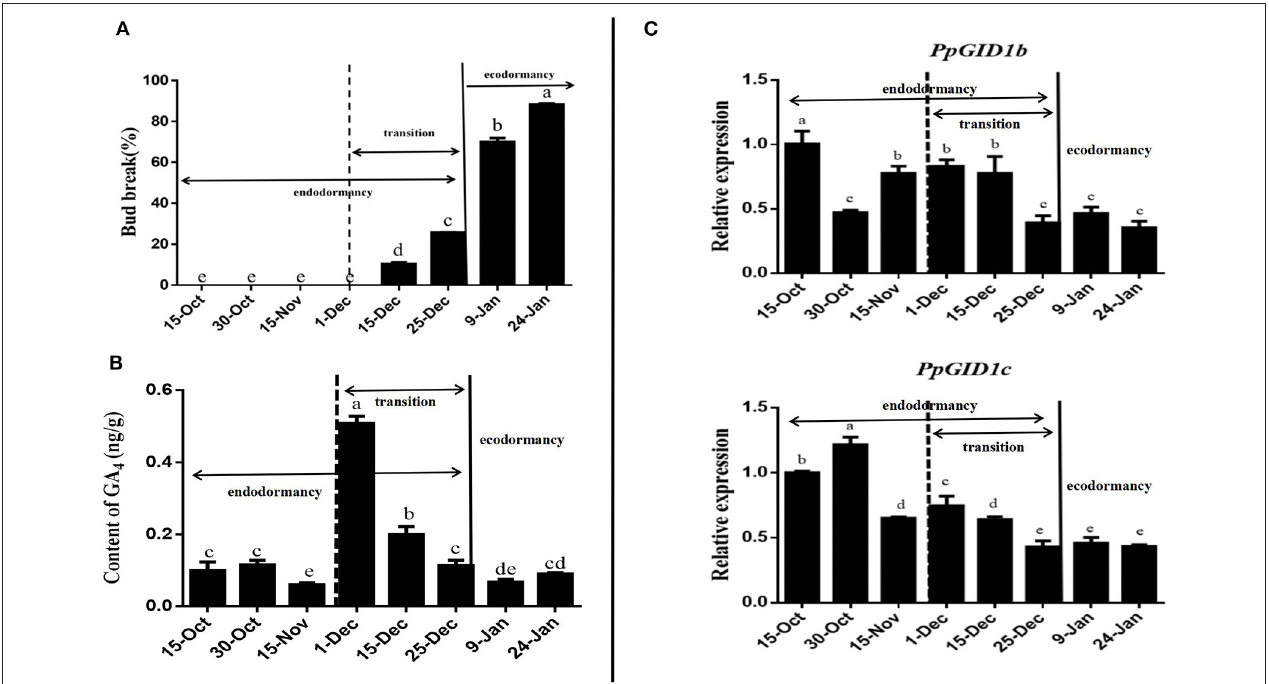
FIGURE 2 | Determination of dormancy progress, GA 4 levels, and the expression of PpGID1 . (A) Bud-break percentage of the Zhongyou 4 variety from October 15, 2018, to January 24, 2019. Annual shoots were collected from peach trees in the field on the dates indicated and placed in water for 25 d before assessment. Shoots with < 50% bud-break were considered dormant, and the values are means of 20 shoots. (B) GA 4 levels in leaf bud determined by liquid chromatography-tandem mass spectrometry (LC-MS/MS). (C) Relative expression of PpGID1b and PpGID1c during peach leaf bud dormancy. Data are means ( ± SD ) of the three biological replicates, and expression is relative to that of PpUBQ . Different letters indicate significant differences between means as determined by an ANOVA followed by Duncan’s multiple range test ( P <